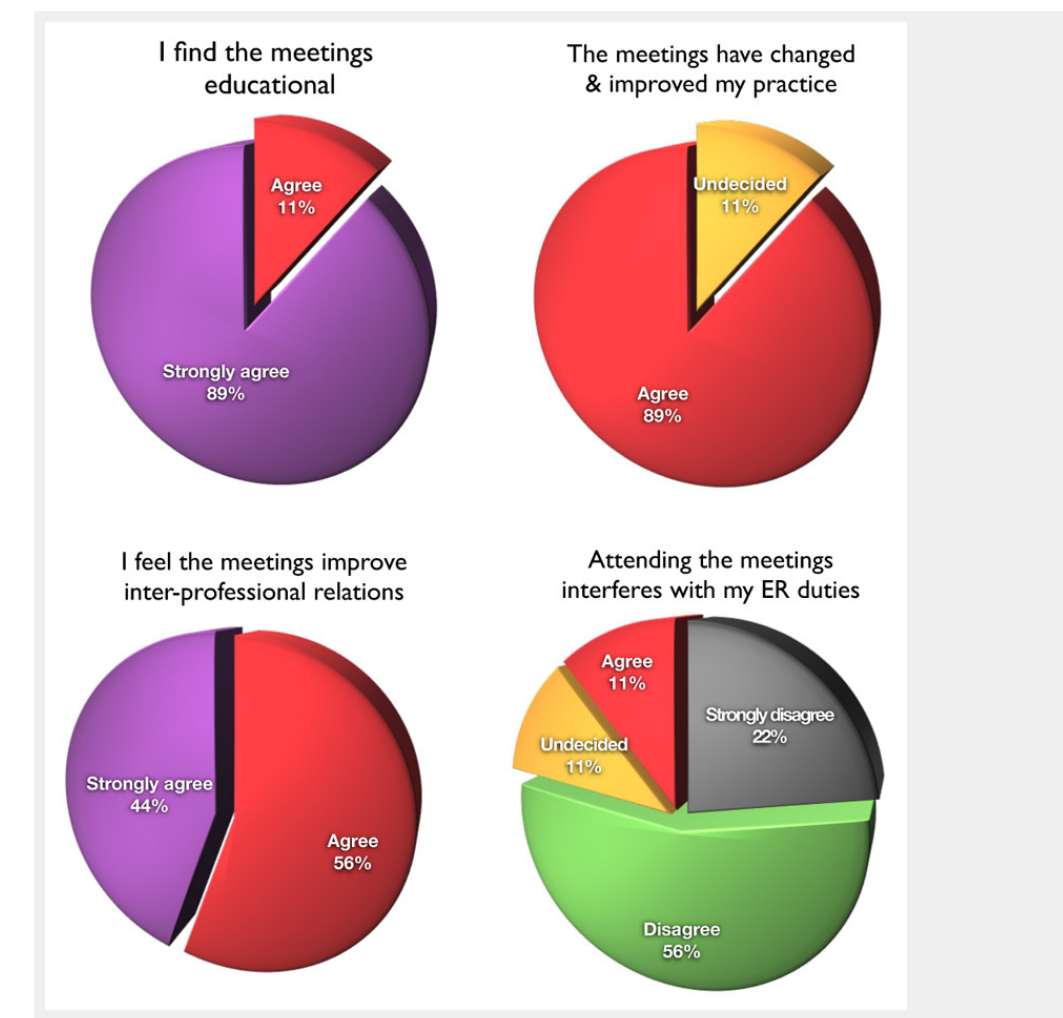
Emergency room staff regarded the pre-fracture-clinic meetings as highly educational to a point where it changed their practice, as well as improving interprofessional relations without impacting on their routine